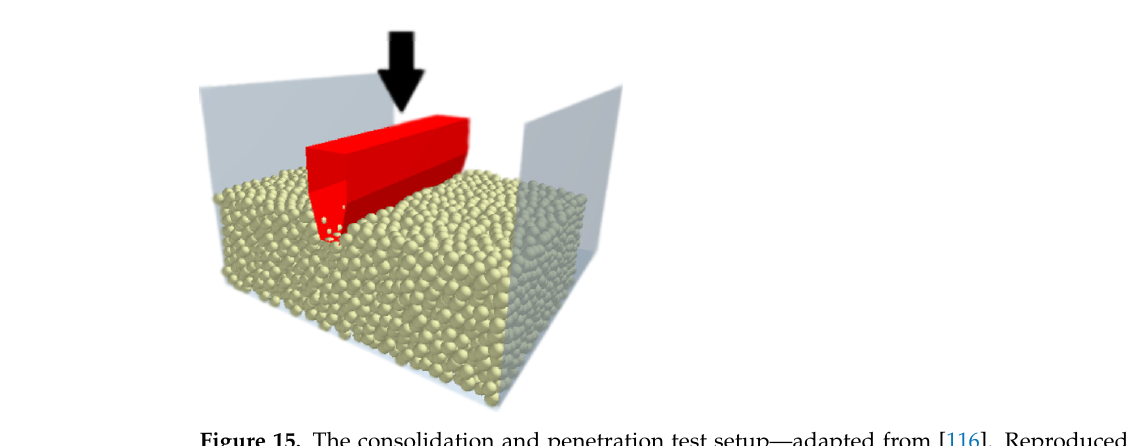
Figure 15. The consolidation and penetration test setup—adapted from [116]. Reproduced with permission from Advanced Powder Technology; published by Society of Powder Technology Japan,